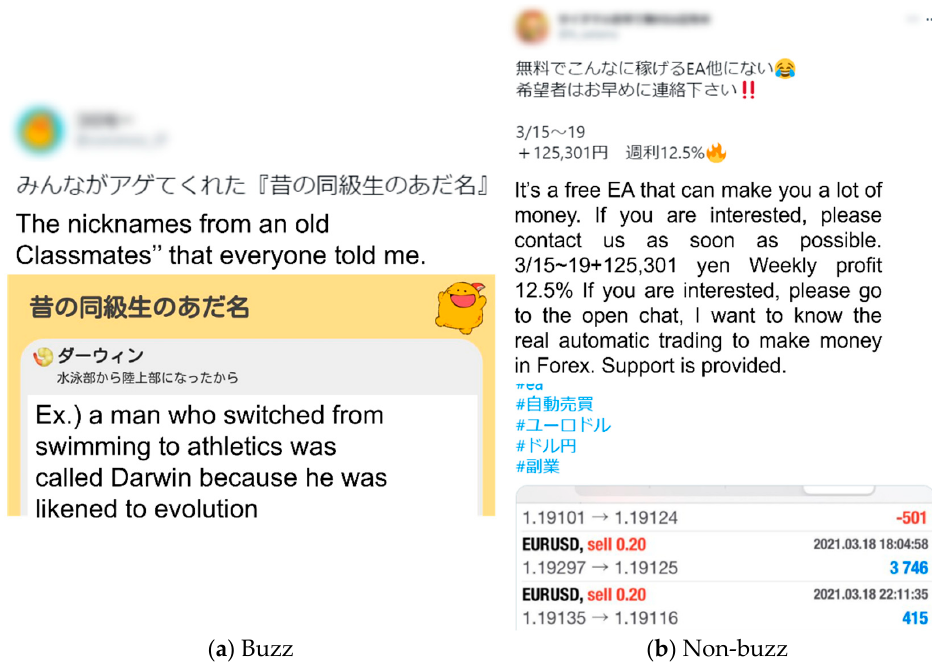
Figure 9. Examples of tweet pairs with high similarity in image features (with VGG16).